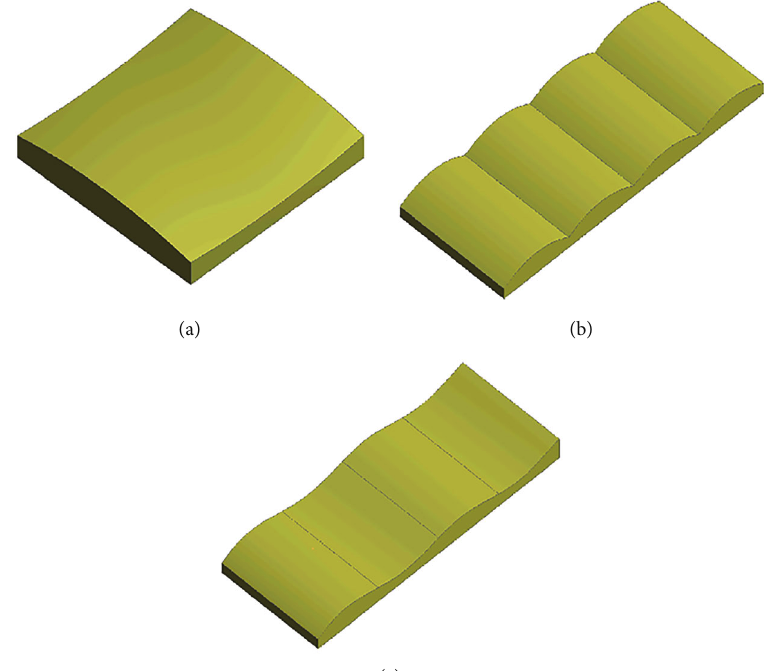
Figure 2: Three di ff erent forms of membrane structure models. (a) Saddle-shaped roof, (b) continuous arch roof, and (c) wave-shaped roof. The speci fi c dimensions are shown in Table 1.